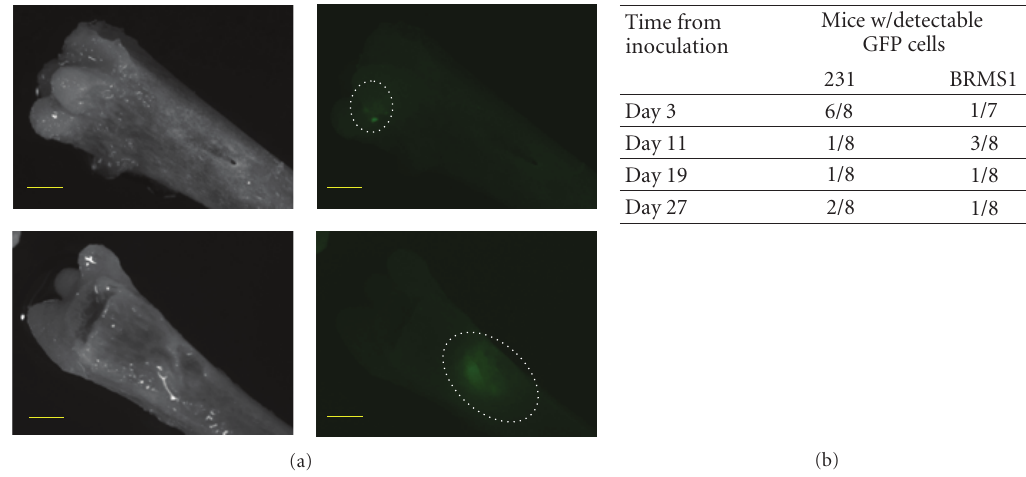
Figure 1: Breast cancer metastases in femoral bone. Female athymic nude mice were inoculated in the left cardiac ventricle with 3 × 10 5 MDA-MB-231 GFP or MDA-MB-231BRMS1 GFP cells, eight per group. Animals were euthanized at day 3, 11, 19, or 27 after injection. Femurs were removed, placed in PBS, and imaged with light and fluorescence stereomicroscopy at a 40x magnification to detect GFP-labeled cancer cell metastases. Images are shown for 27 day metastases (a) of MDA-MB-231BRMS1 (top) and MDA-MB-231 (bottom). Note colony size di ff erence between the two variants. Scale bar = 1mm. Table (b) summarizes the incidence of detectable GFP-expressing cells for each injection